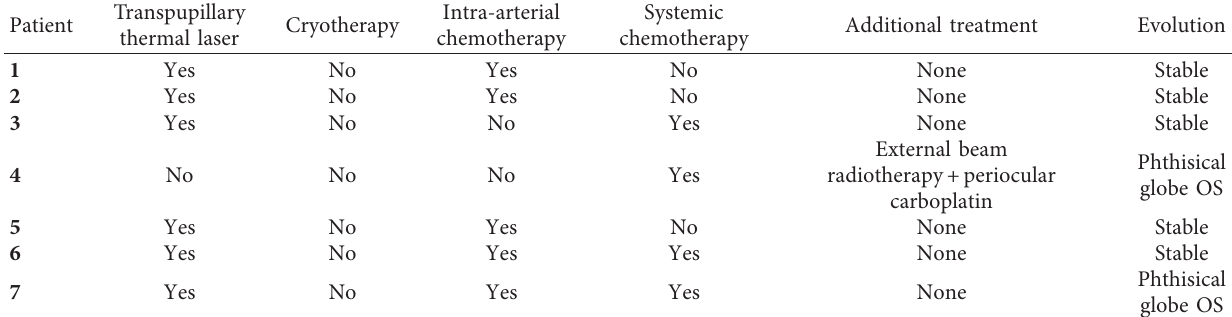
Table 3: Treatments received and